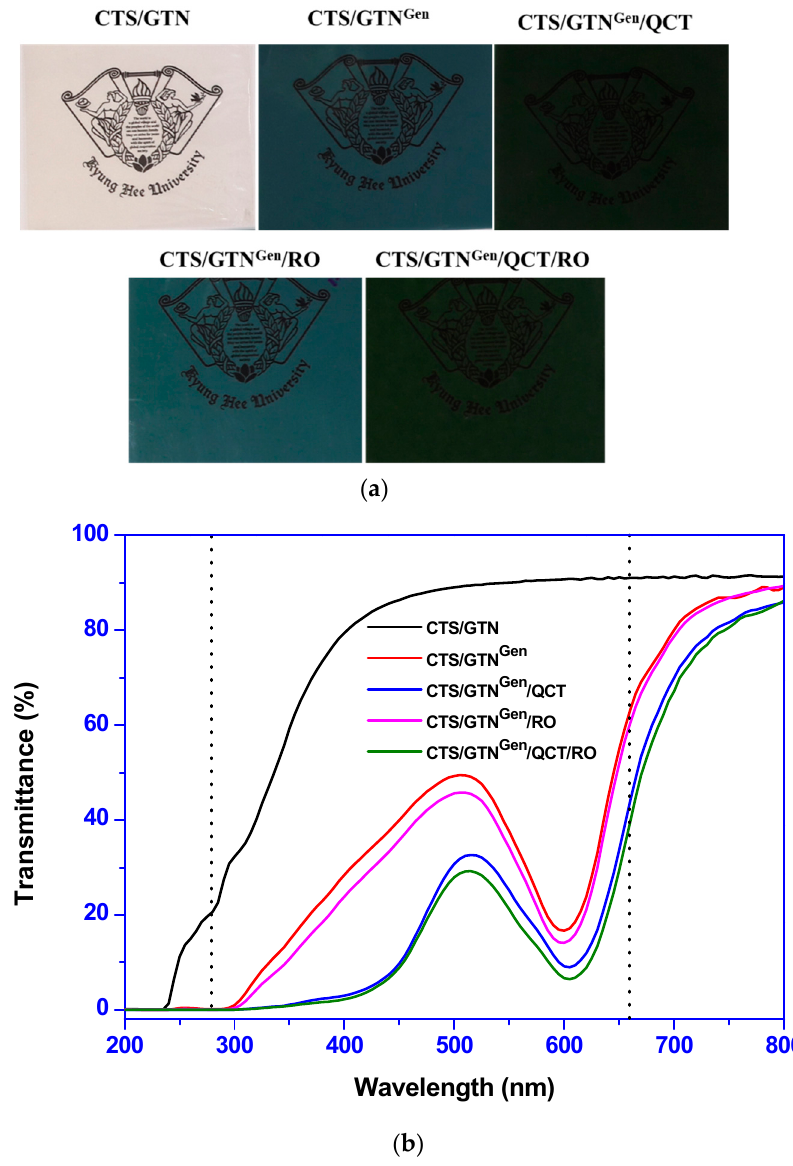
Figure 1. The appearance ( a ) and light transmission spectra ( b ) of the chitosan/gelatin-based films. Table 1. Surface color and light transmittance of the chitosan/gelatin-based